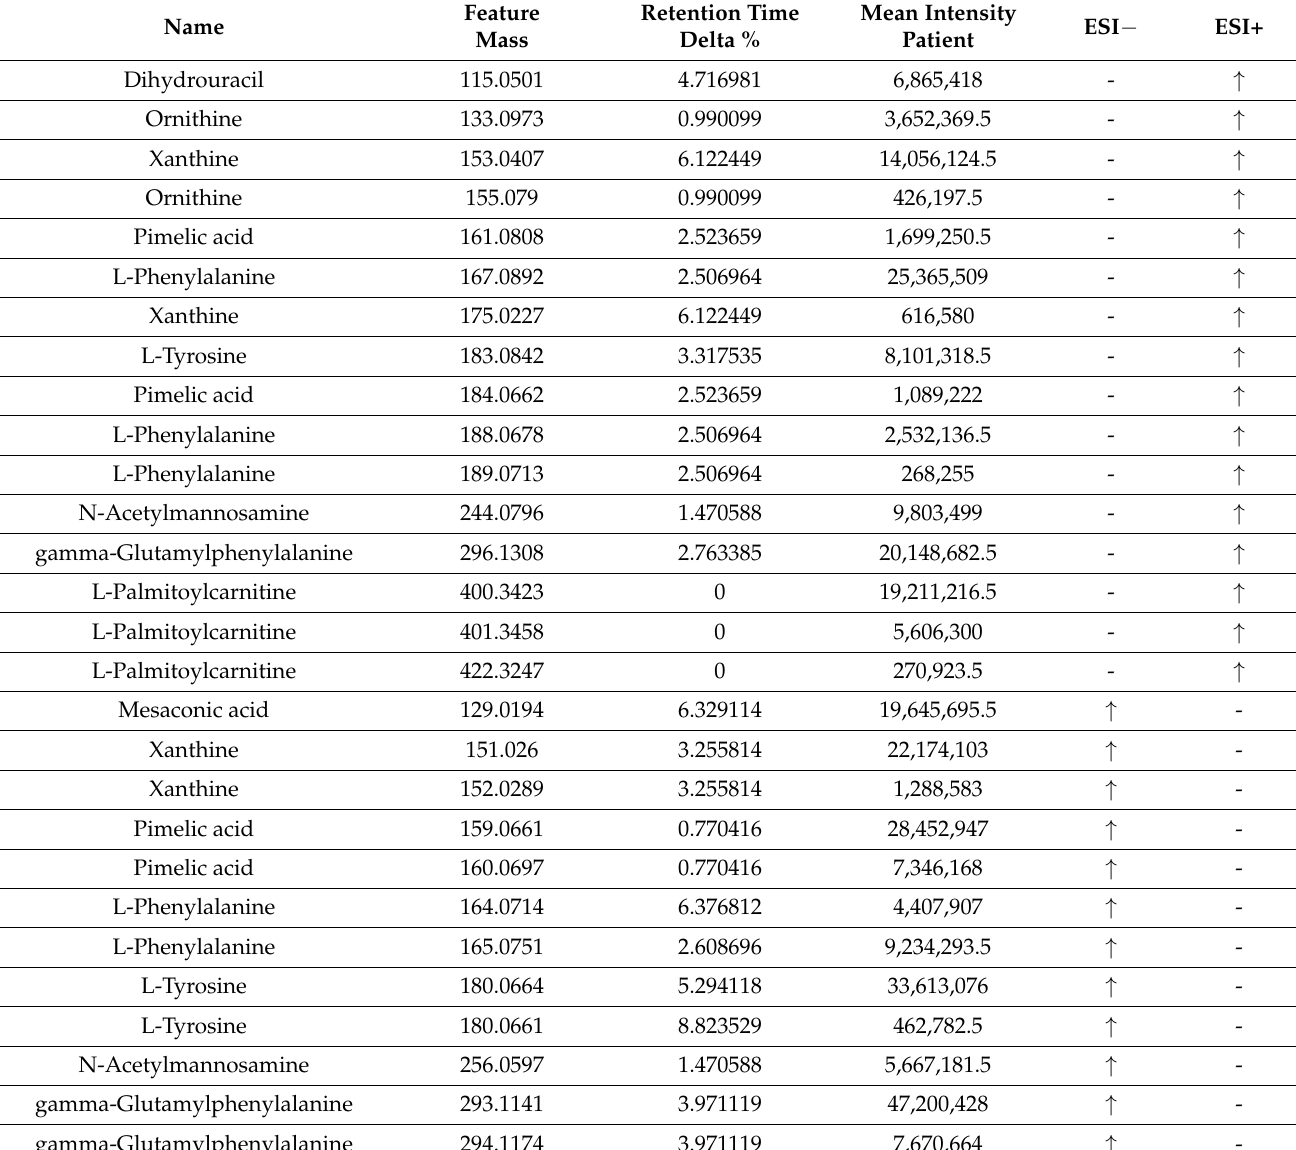
Table 1. Table of spiked metabolites as reported for the validation plasma described in Section